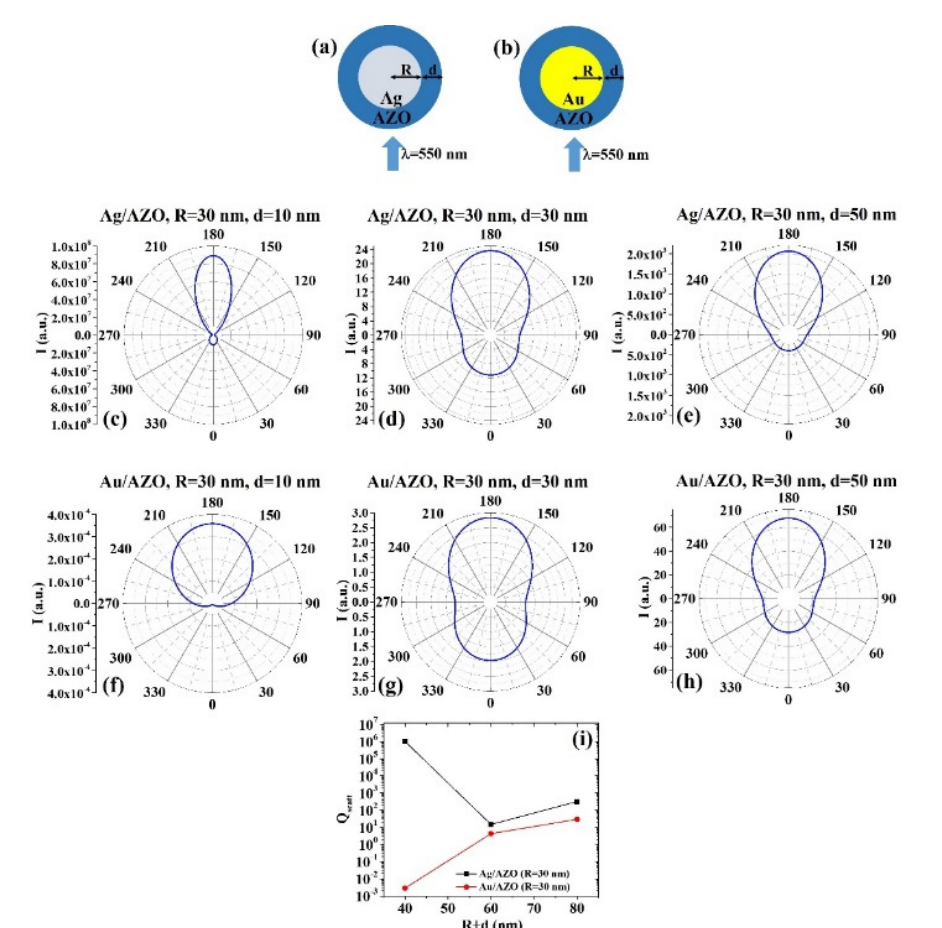
Figure 2. ( a , b ) Scheme of the structure of the simulated Ag/AZO ( a ) and Au/AZO ( b ) core–shell spherical particle with core radius R and shell width d and electromagnetic radiation of wavelength λ = 550 nm impinging on the particle from 0°. ( c – e ) Calculated polar diagrams for the intensity of the scattered light from the Ag/AZO core–shell spherical particle fixing the Ag core radius R to 30 nm and increasing the AZO shell width from 10 nm to 50 nm. ( f – h ) Calculated polar diagrams for the intensity of the scattered light from the Au/AZO core–shell spherical particle fixing the Au core radius R to 30 nm and increasing the AZO shell width from 10 nm to 50 nm. ( i ) Calculated scattering efficiency for the light (wavelength λ = 550 nm) scattering process of the Ag/AZO (black dots) and Au/AZO (red dots) core–shell spherical particles fixing the core radius to R = 30 nm and increasing the AZO shell width d from 10 nm to 50 nm. (b) R = 50 nm: Figure 3a,b reports the scheme of the structure of the simulated Ag/AZO (Figure 3a) and Au/AZO (Figure 3b) core–shell spherical particle with core ra- dius R and shell width d and electromagnetic radiation of wavelength λ = 550 nm imping- ing on the particle from 0°; in Figure 3c–e the calculated polar diagrams for the intensity of the scattered light from the Ag/AZO core–shell spherical particle fixing the Ag core radius R to 50 nm and increasing the AZO shell width from 10 nm to 50 nm are reported;